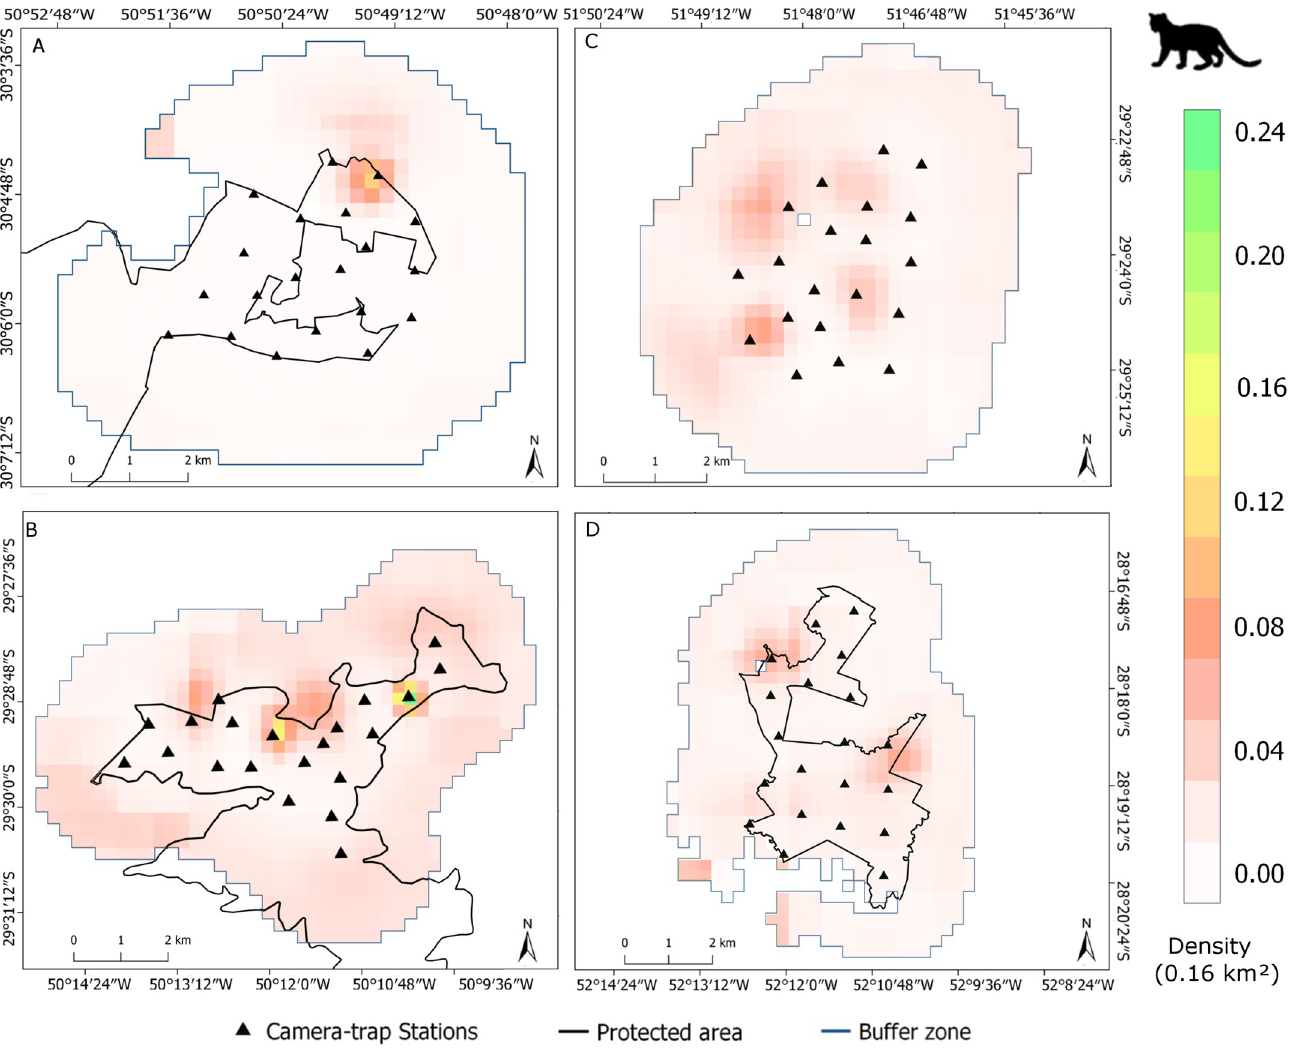
Fig 7. Margay density maps in the sampled areas. Realized density based on estimates of the best SCR model derived from the camera-trap sampling. A) Banhado dos Pachecos Wildlife Refuge (BPWR), B) Center for Research and Conservation of Nature Pro´-Mata (PROMATA), C) Teutoˆnia (TEUT), D) Passo Fundo National Forest (PFNF). Water bodies were removed in A and D. Density scales are specific to each map. Pixel resolution at 250 x 250m; density scales are in margay individuals per 0.16 km 2 .